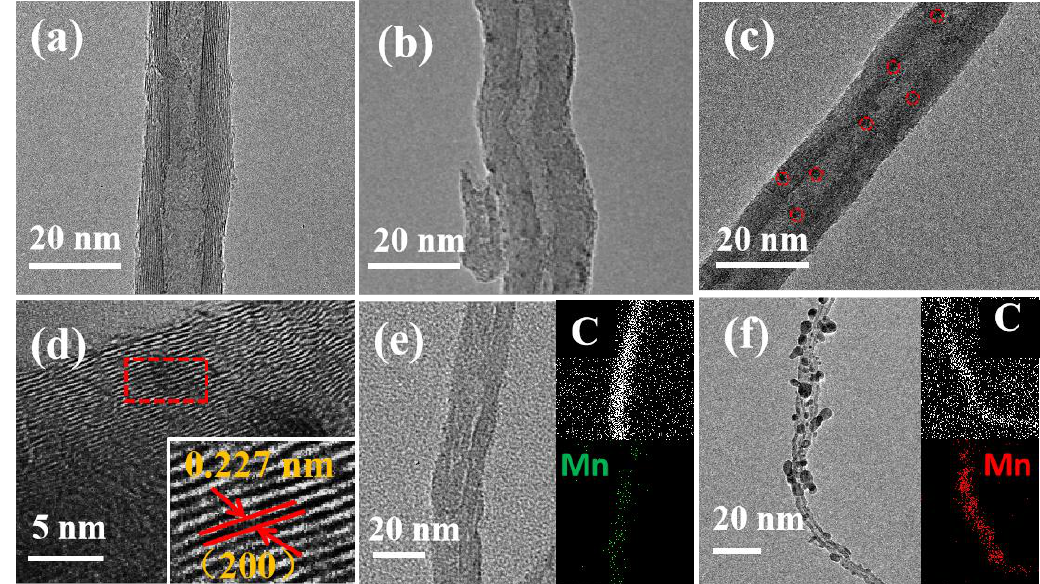
Figure 3. TEM image of oxidized CNTs ( a ) Mn(Ac)OH / CNTs ( b ), MnO / CNTs ( c ), HRTEM image of MnO / CNTs using the fast Fourier transform (FFT) ( d ), and EDS element mapping images of Mn(Ac)OH / CNTs ( e ) and MnO / CNTs ( f ).